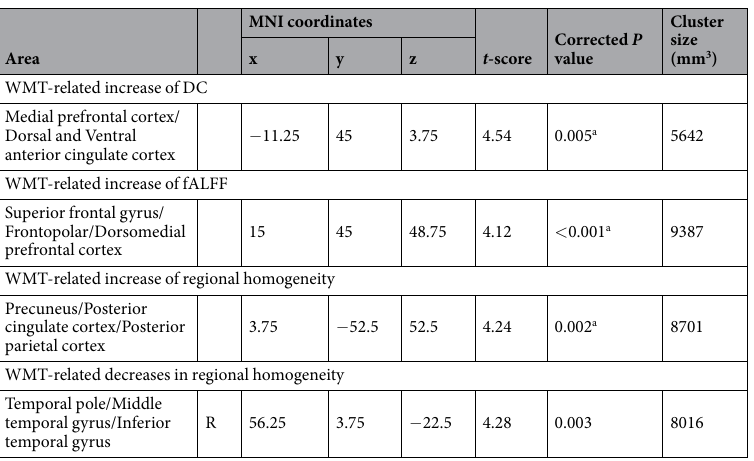
Table 1. Brain regions with significant WMT-related changes in rsfMRI measures. a Corrected for multiple comparison at the cluster size at the whole brain level. b Corrected for multiple comparison at the cluster size within the region of